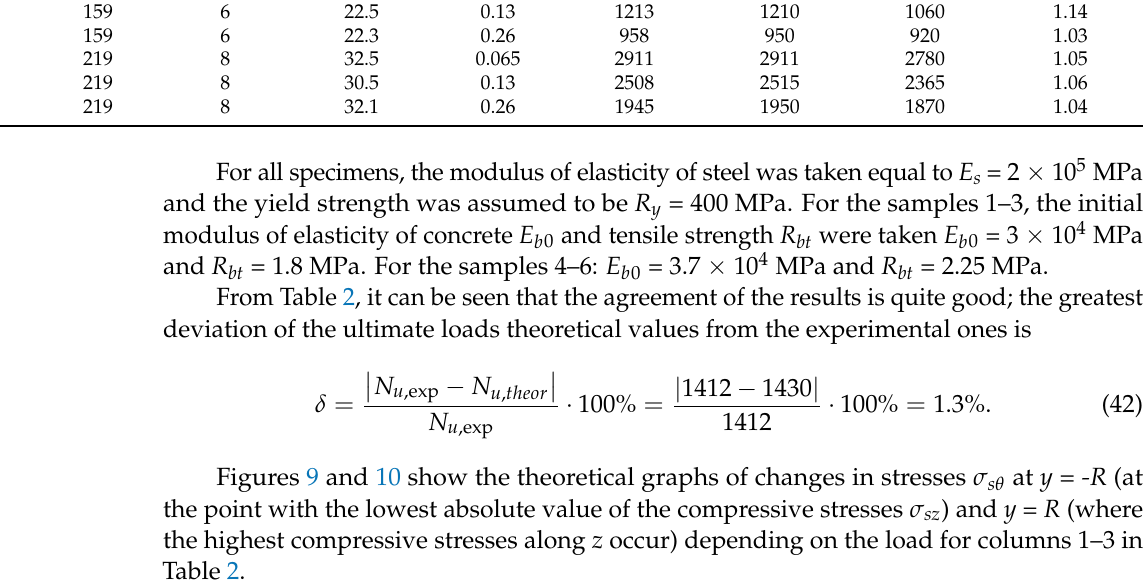
Figure 10. Dependence of stresses σ s θ at y = R on load.